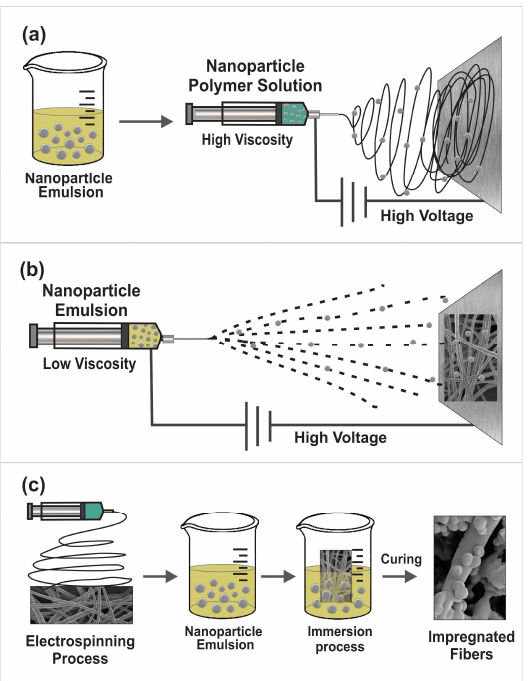
Figure 3. Incorporation of loaded nanoparticles into electrospun mats: ( a ) incorporation of nanoparticles by mixing in the polymer solution; ( b ) depositing nanoparticles on nanofiber mat via electrospray; and ( c ) impregnation of nanofiber mats with nanoparticles via immersion.